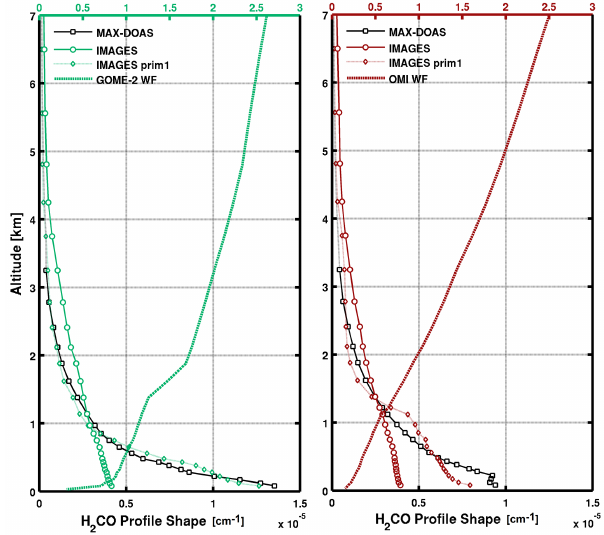
Figure 13. IMAGES CTM and MAX-DOAS retrieved H 2 CO pro- file shapes (concentration profiles divided by their total columns) averaged in June 2010 in Xianghe. IMAGES prim1 includes an ad- ditional primary source, as reported by Chen et al. (2014). The cor- responding mean satellite scattering weighting functions are also